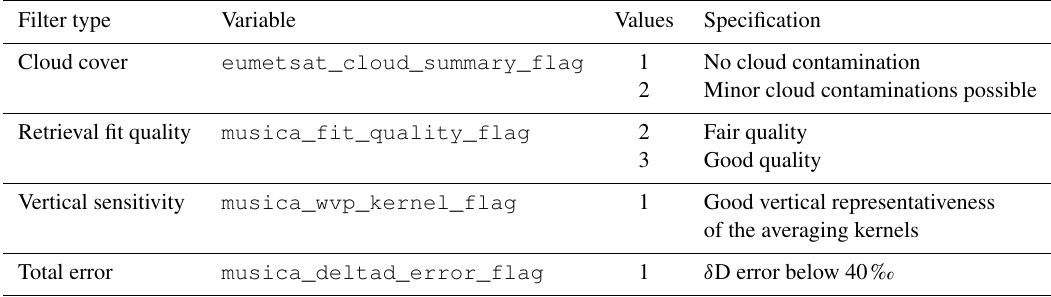
Figure 5. Effects of individual filter criteria on the corresponding metrics, along the Metop-A orbit 55524, as also shown in Fig. 4. The grey scatter shows all observations along the specific orbit, the cyan scatter shows the available data for each variable according to its individual filter criterion and the dark blue scatter shows the available data when simultaneously filtering for all four metrics. The metrics (a–c) are used to define the flag musica_wvp_kernel_flag , and the noise in (d) is used for the flag musica_deltad_error_flag (compare with Table 1). Table 1. Diagnostic flag variables and their recommended values for selecting MUSICA IASI {H 2 O, δ D} pair data with high quality. The flags indicating the vertical sensitivity ( musica_wvp_kernel_flag ) and uncertainty ( musica_deltad_error_flag ) of the {H 2 O, δ D} pair product are individually set for each altitude level, while the flags for the cloud cover ( eumetsat_cloud_summary_flag ) and the retrieval fit quality ( musica_fit_quality_flag ) are not height-dependent (Schneider et al., 2021a). The vertical sensitivity flag depends on the measurement response, information displacement and vertical resolution of the {H 2 O, δ D} pair kernels, and the total error flag depends on the sum of the temperature and noise error of δ